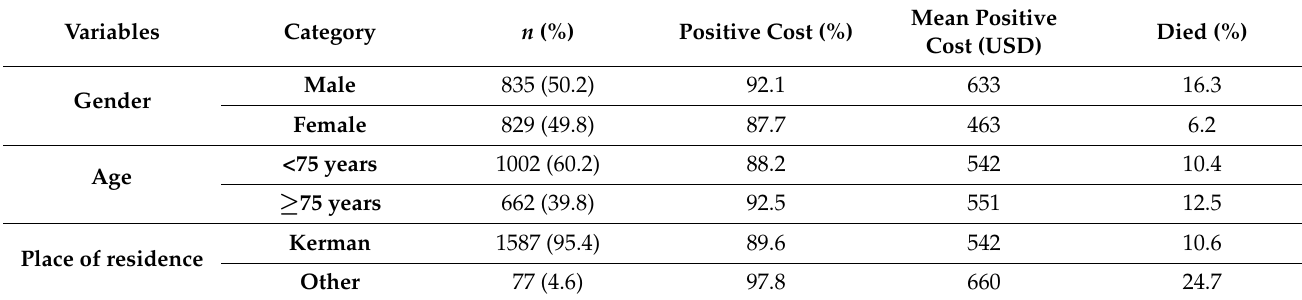
Table 5. Summary of time-independent covariates (gender, age, and place of residence) fitted to the HDK dataset.